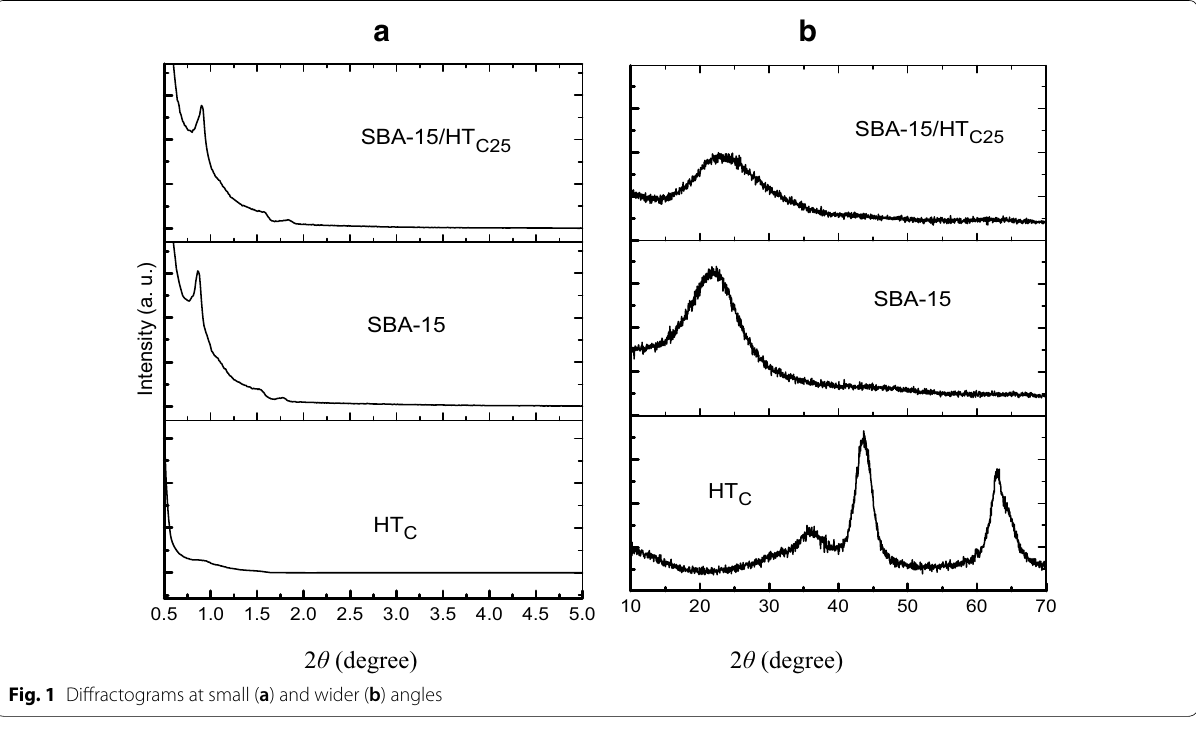
Fig. 1 Diffractograms at small ( a ) and wider ( b ) angles